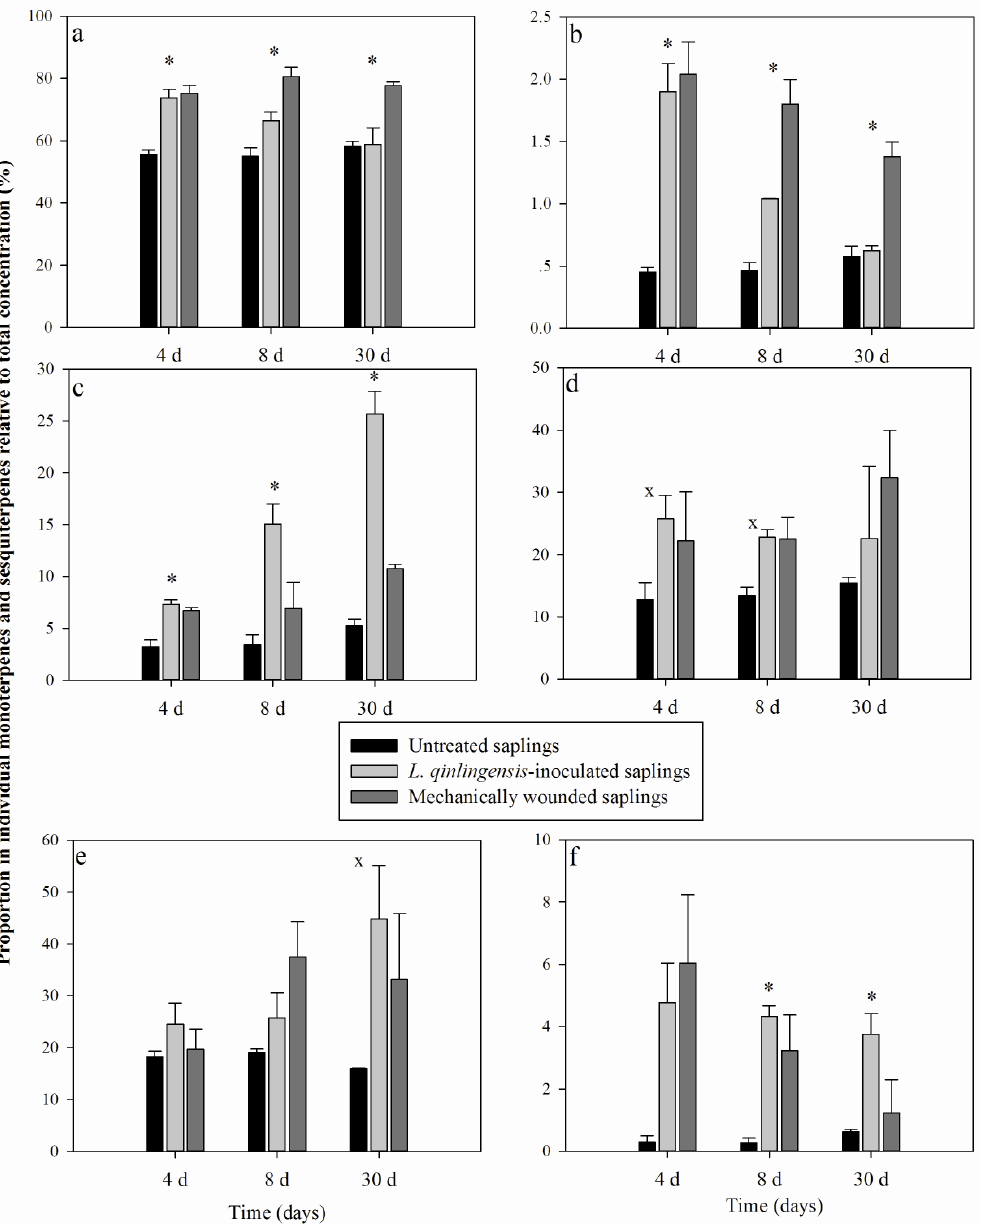
Figure 2. The proportional individual monoterpene and sesquiterpene concentrations (%) in the xylem of the stem of P. armandi saplings relative to total concentrations differ among treatments at each time point. a = α -pinene; b = bornyl acetate; c = limonene + β -phellandrene; d = longifolene; e = germacrene; f = δ -cadinene; * indicates that there was a significant difference ( p < 0.05) between treatments using ANOVA at each time point and x indicates that there was a significant difference ( p < 0.05) among L. qinlingensis -inoculated saplings and untreated saplings using ANOVA at each time point; Each bar represents the mean total ± standard error of three